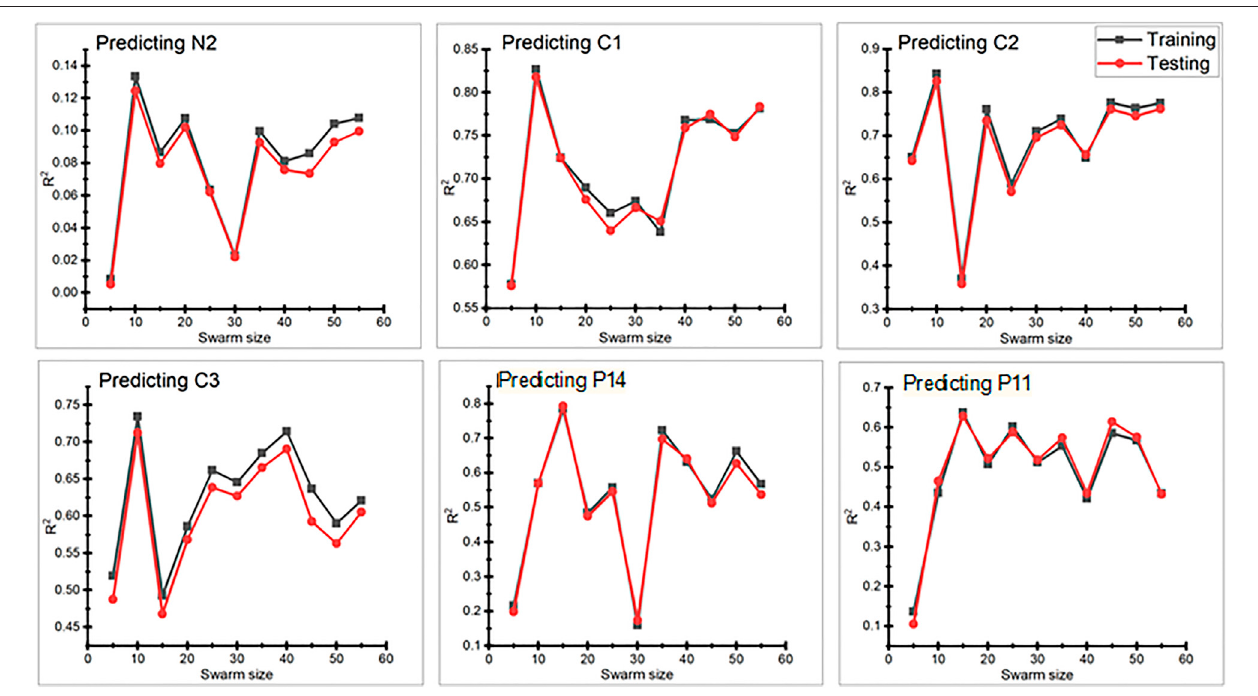
FIGURE 6 | Calculation of optimum swarm sizes with respect to R 2 .